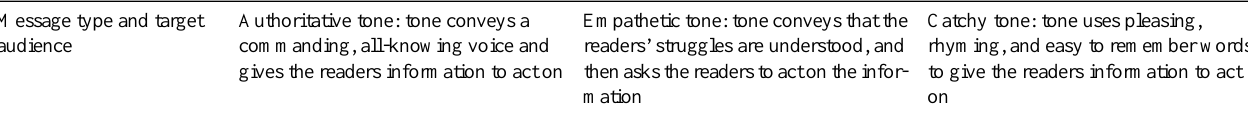
Table 1. Example educational and strategy messages by varying tones of voice and target audience used in testing phases (these messages are the revised versions modified after face validity testing by the expert